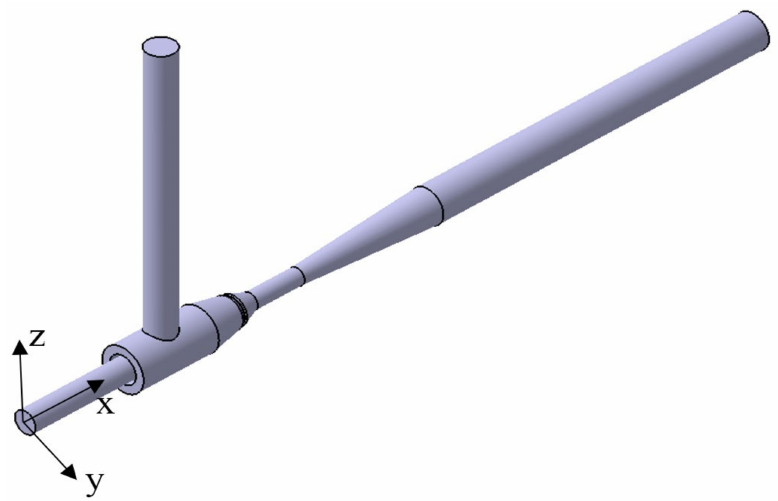
Figure 2. Computational domain model of jet fish pump.